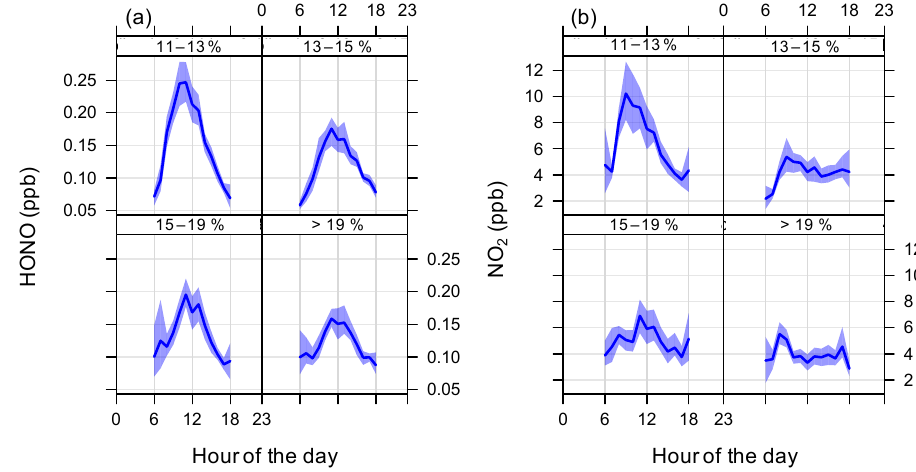
Figure 11. (a) HONO and (b) NO 2 diurnal cycles over the 3-month measurement period, divided into four soil water content (SWC)% bins. SWC data have been obtained from the Australian Water Resources Assessment Modelling